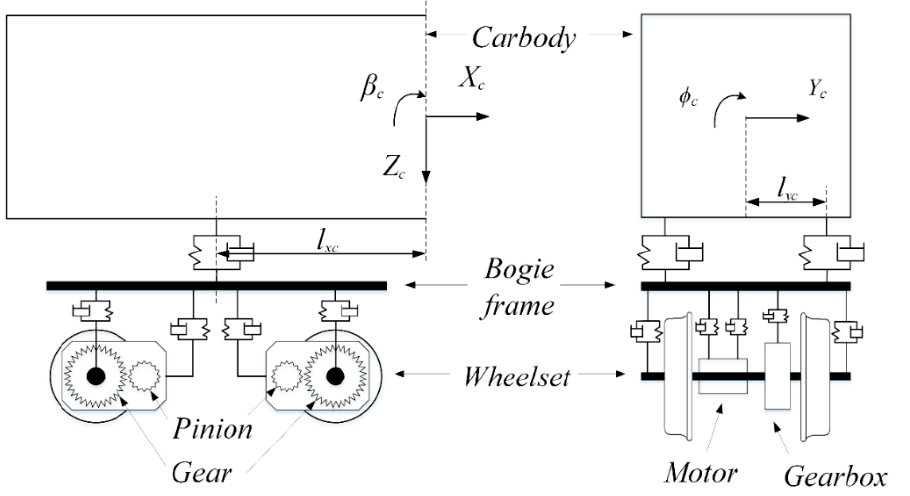
Figure 3. Vehicle system dynamics model. Table 1. Degrees of freedom for the railway vehicle.